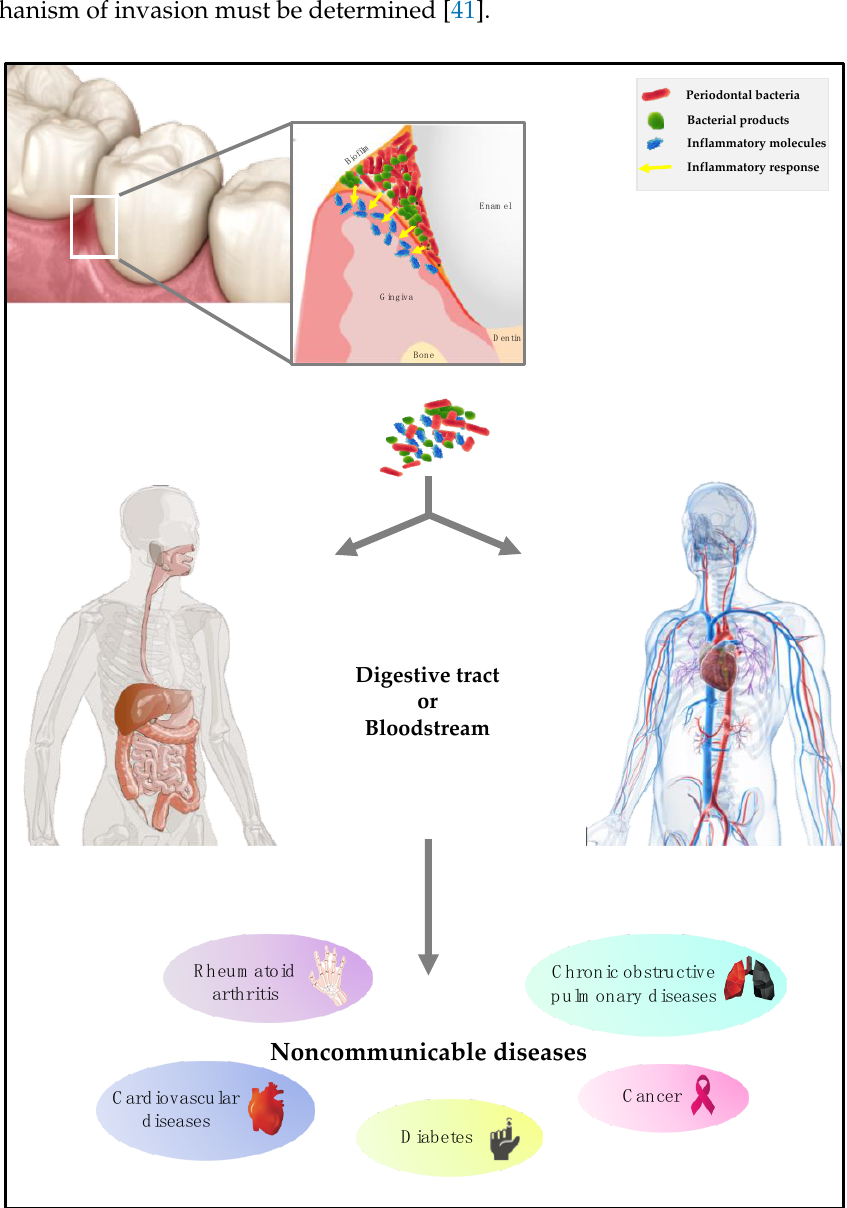
Figure 1. Process of invasion of the body by periodontal bacteria.